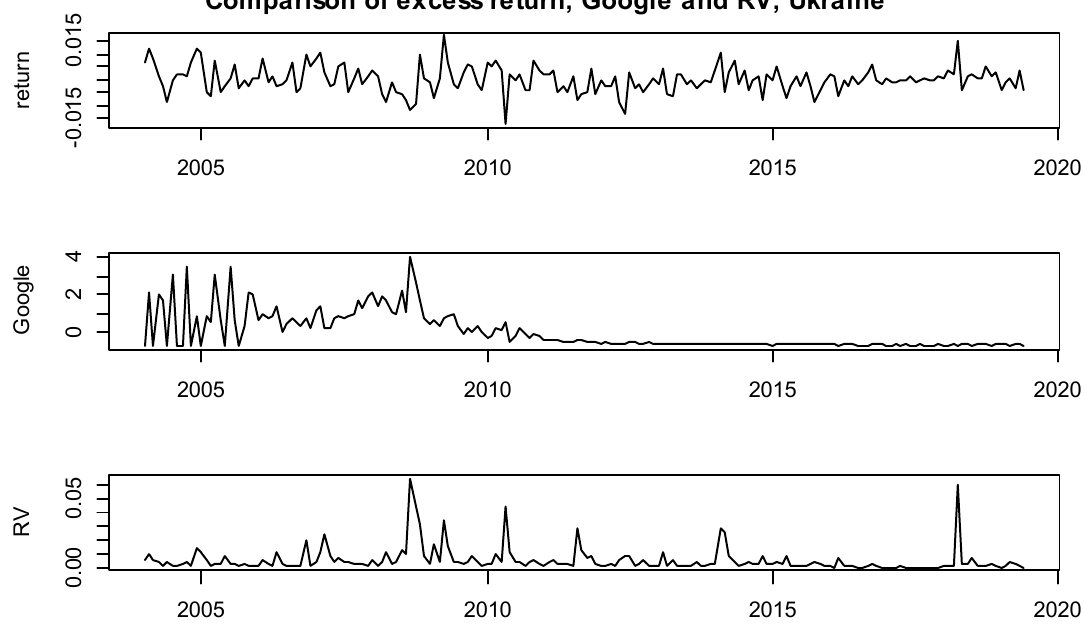
Figure A3. Comparison of monthly series: Excess return, RV and Google search volume, Croatia.